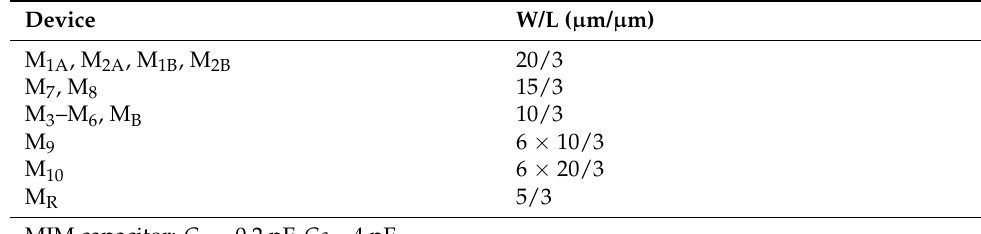
Table 2. Transistor aspect ratios of the DDTA.